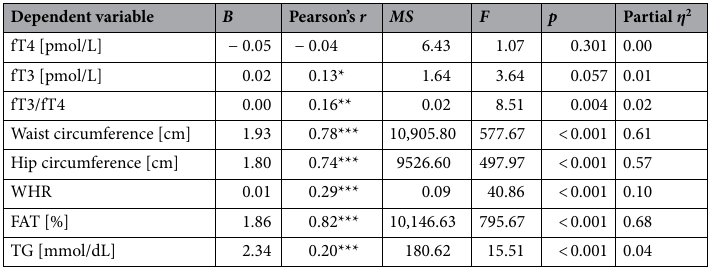
Table 3. The results of single between-subject effects tests for BMI covariate. WHR waist hips ratio, *p < 0.05, **p < 0.01, ***p < 0.001.